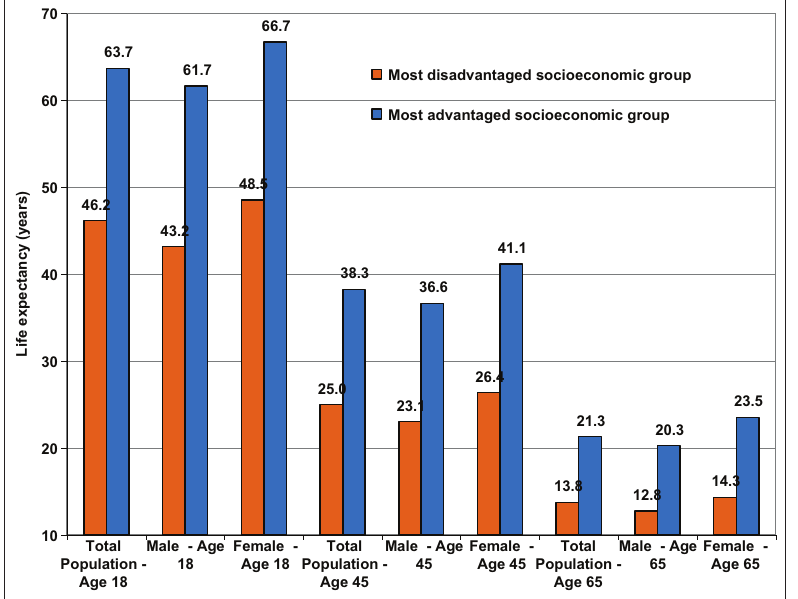
Figure 2: Life Expectancy of the Most Disadvantaged and Most Advantaged Socioeconomic Groups by Age and Sex, United States, 1997-2014 The most disadvantaged socioeconomic group consisted of adults with less than a high school education and family income below the poverty level. The most advantaged socioeconomic group consisted of adults with a master’s or higher degree and family income at or above 400% of the poverty threshold. Differences in life expectancy between the most advantaged and most disadvantaged socioeconomic groups across all sex and age groups were statistically significant at